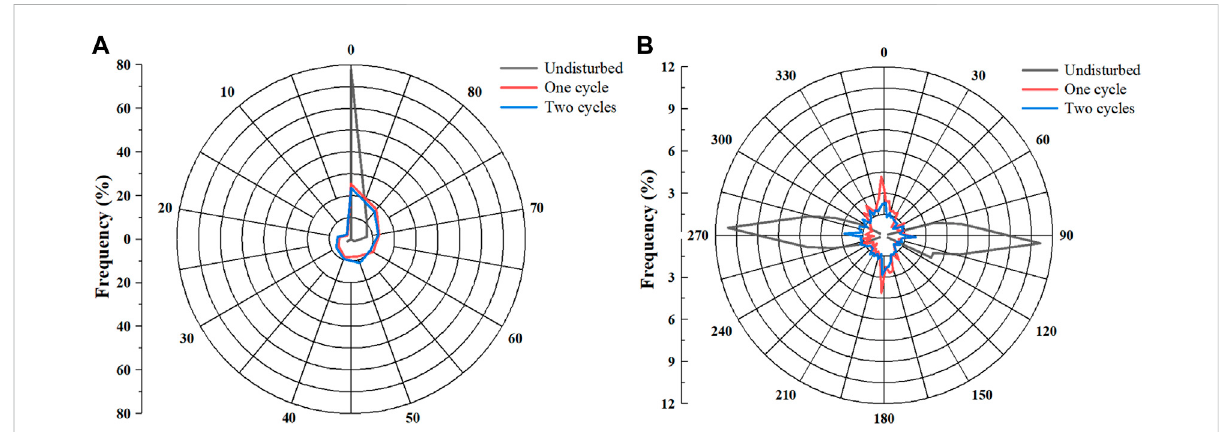
Figure 7 displayed the 3-D pore model after different wet-dry cycles. Figure 7A presented the undisturbed red-bed